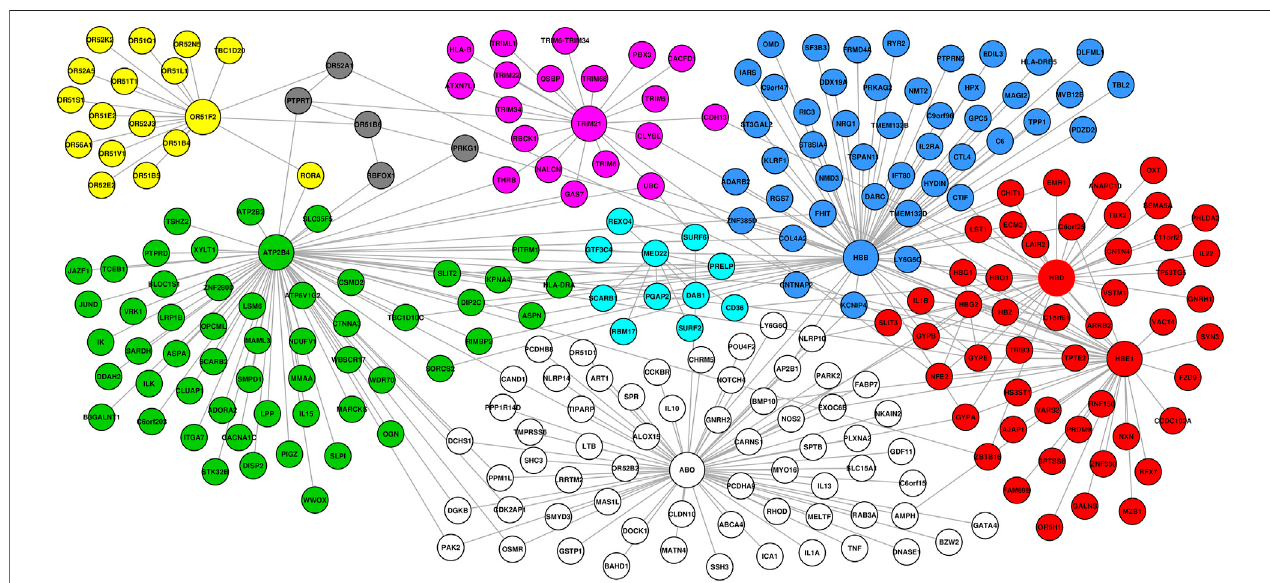
FIGURE3| Networkgeneratedfrompredominantseveremalariaprotectivecandidategenes,comprising351interactionsbetween268nodes. Topologyanalysis identi fi ed ABO, HBB, HBD, HBE1, and ATP2B4 as highly in fl uential connector hub genes in fl uencing at least two subnetworks/communities, while TRIM21 and OR5F2 constituted independent communities. MED22 and OR551B6 constituted provincial hub